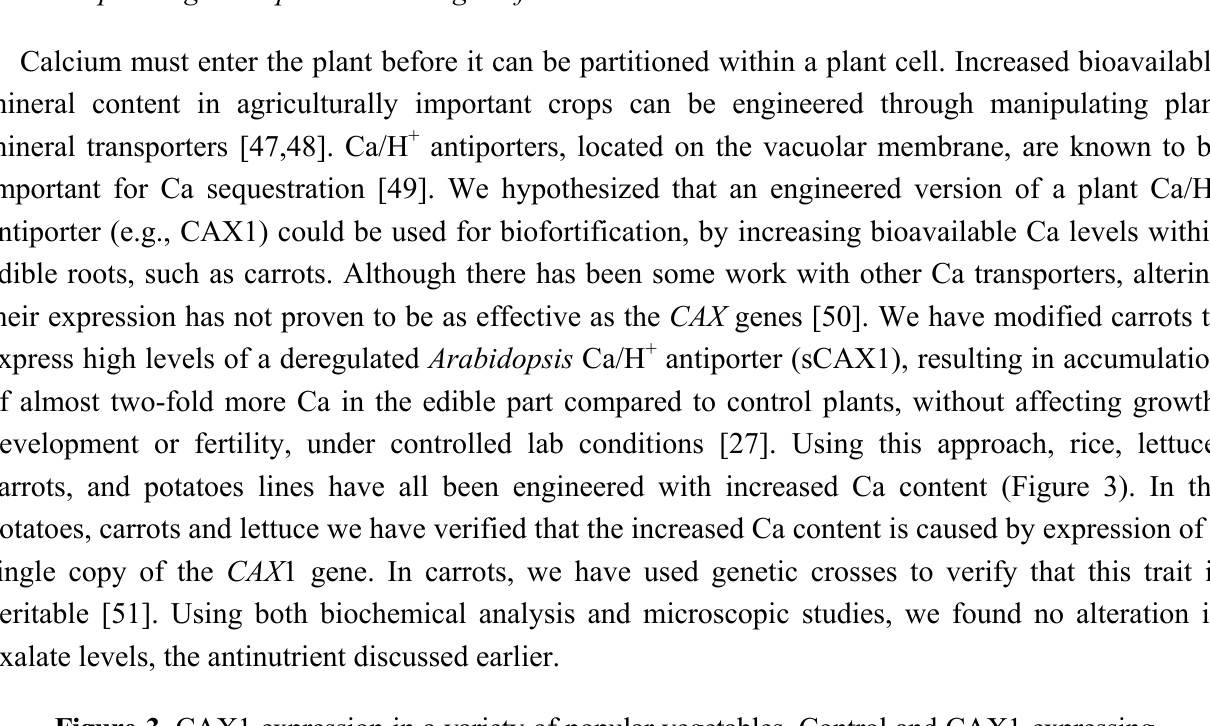
Figure 3. CAX1 expression in a variety of popular vegetables. Control and CAX1-expressing plants are indistinguishable in terms of yield, oxalate levels and growth characteristics; however, the amount of calcium is increased in the transgenic lines